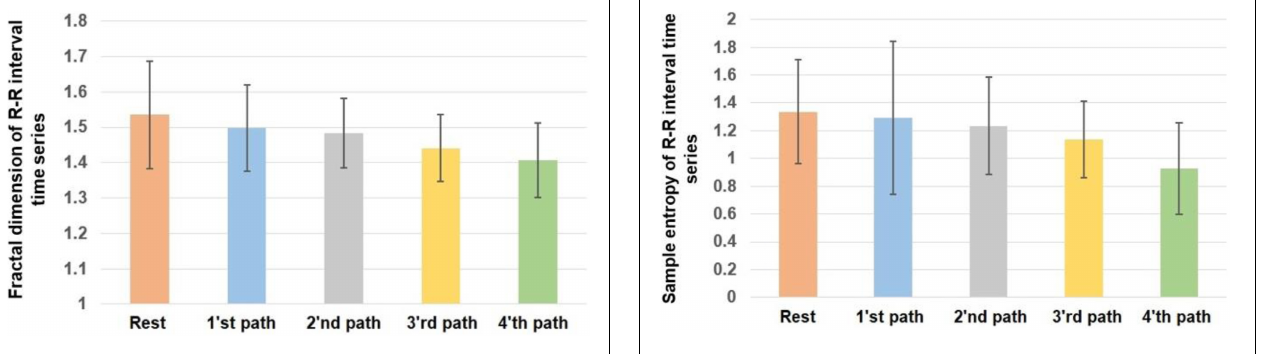
FIGURE 5 | The sample entropy of heart rate variability. Error bars indicate the SD. TABLE 3 | Comparing the sample entropy of